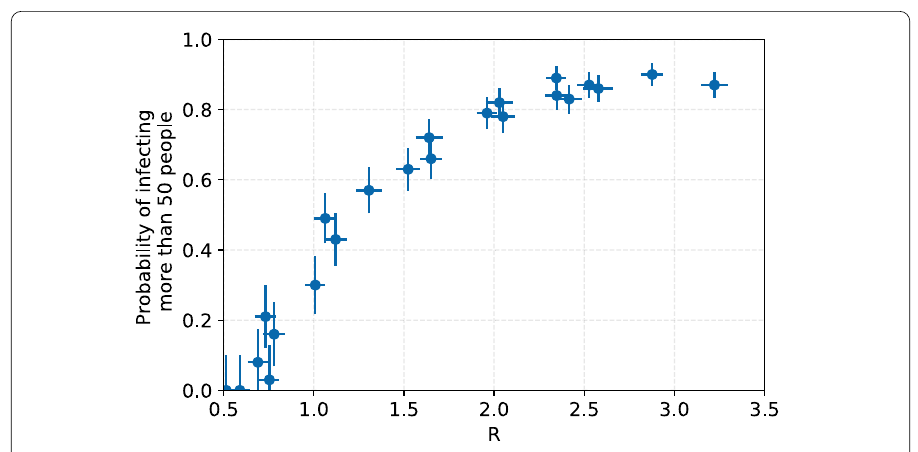
Figure 13 The probability for an outbreak to start as a function of the reproductive number at the time when patient 0 enters a fully susceptible population. An outbreak here is defined as more than 50 people becoming infected. The error bars shown are